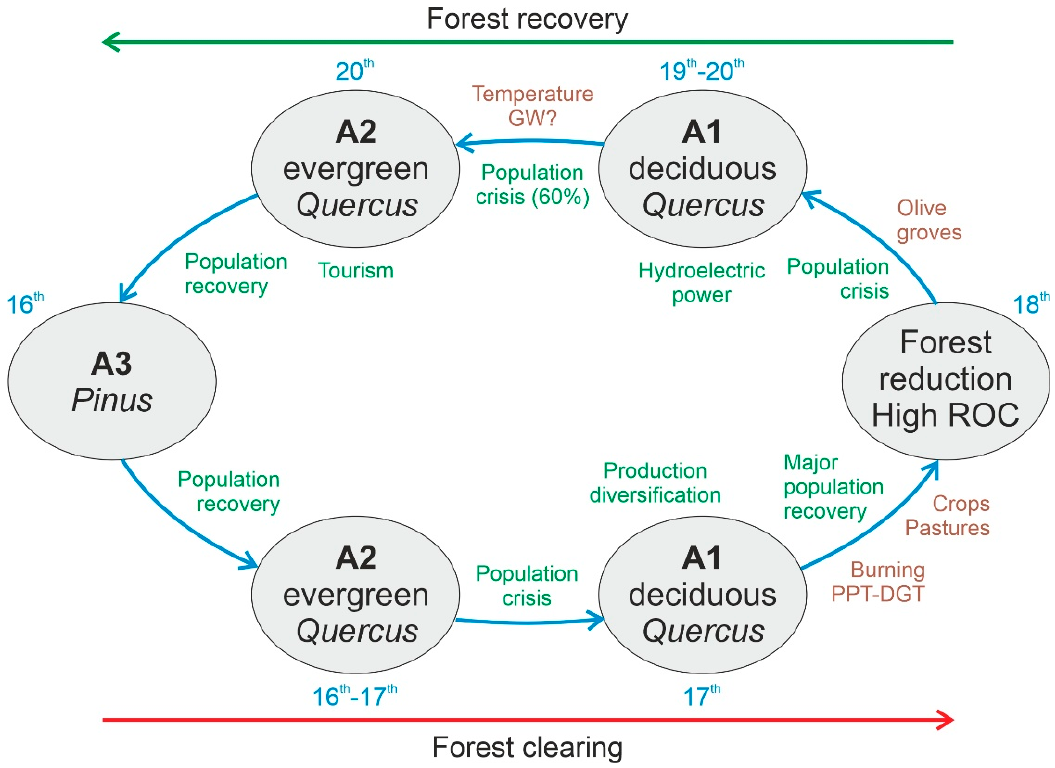
Figure 16. Successional trends of Montcortès forests, as represented by the main successional stages (in bubbles), the external drivers analyzed in this paper (brown text), and the information from historical documentation (green text). Centuries are indicated by blue text.